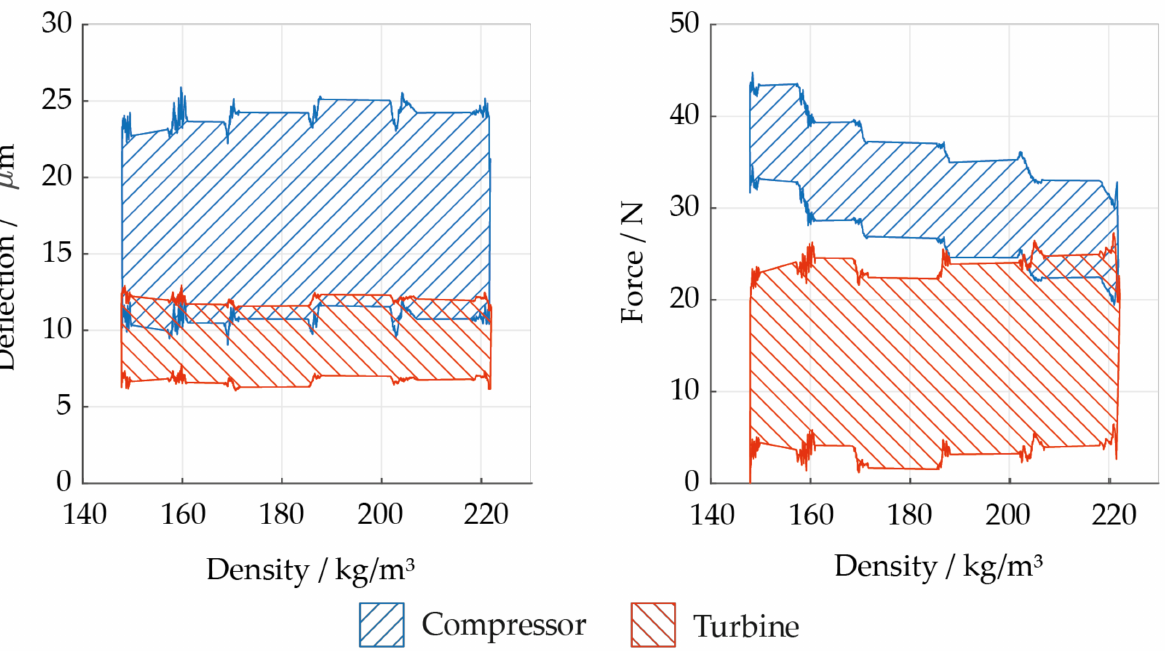
Figure 12. Deflection of the rotor and radial force of the bearings on turbine and compressor over density inside generator cavity at constant rotational speed of 27,500 rpm: ( left ) deflection; ( right )